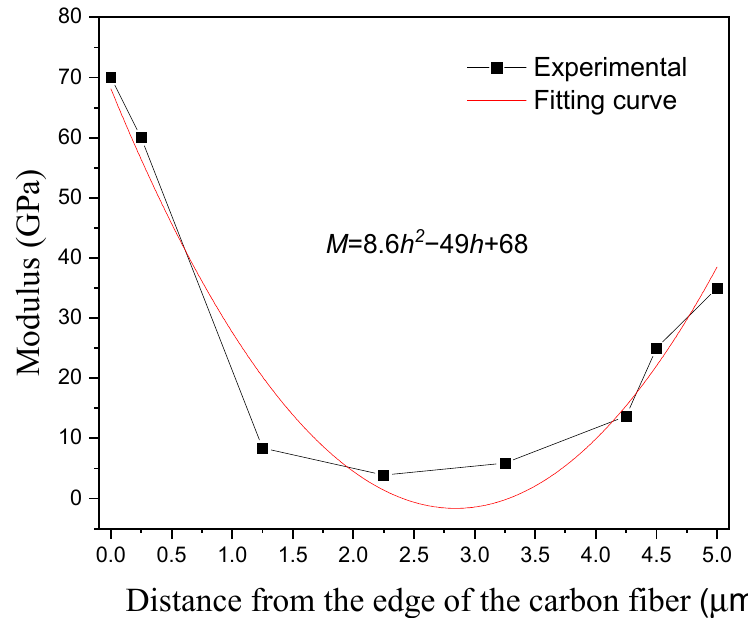
Figure 8. Experimental (symbols) and fitted (curve) modulus along the CD segment in Figure 6.